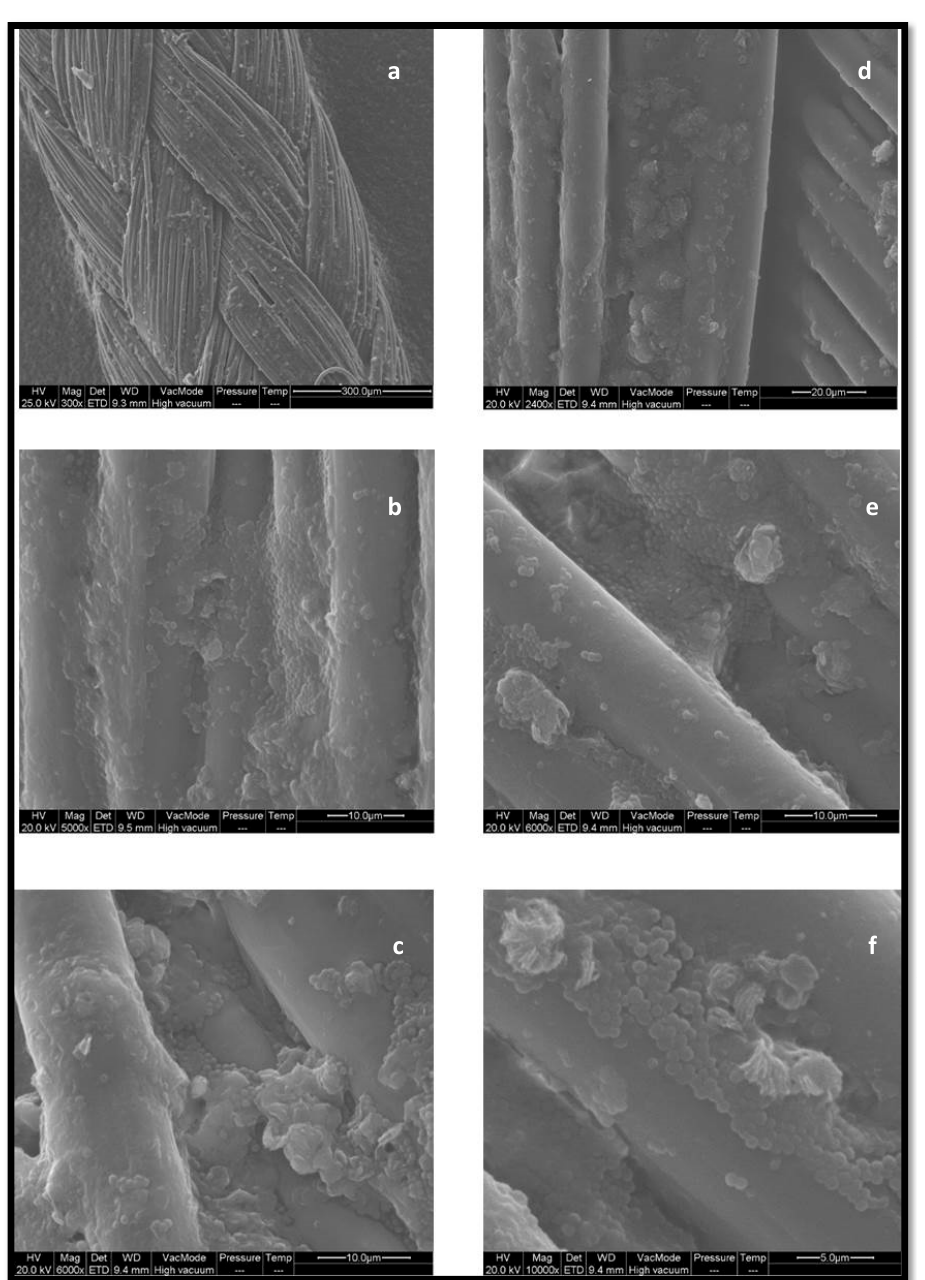
Figure 2. Gauge 2 suture thread (Coated, Braided Lactomer 9-1) colonized by S. epidermidis biofilm observed under SEM with increasing magnification ( a , b Mag. 5000 × ; c – e Mag. 6000 × ; f Mag. 10,000 × ). The images evidence a well-developed microcolony, surrounded by regions of multilayered cells in the relatively flat biofilm.